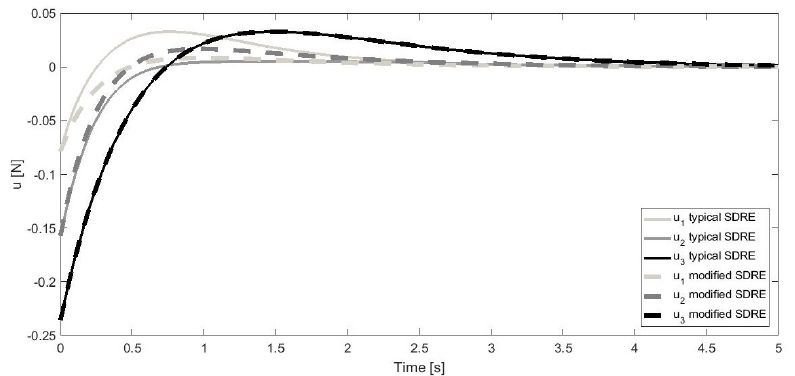
Figure 3. Time plot of velocities.